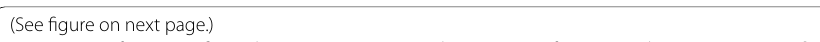
figure on next Fig. 2 Map of site‑specific N ‑glycan processing onto the structure of HIV‑1 envelope: a JR‑FL strain, b BG505 strain, and c B41 strain. The fully glycosylated models were created with JR‑FL ΔCT (PDB: 5FUU), BG505 SOSIP (PDB: 5FYK), and B41 SOSIP. The surfaces of the trimers are represented in grey, and the glycans are represented as spheres colored by the proportion of oligomannose content at that site. The glycans are shown in ball‑and‑stick representation: > 75% high mannose (green), > 75% complex type glycosylation (purple), mixture of high mannose and complex type glycosylation (25% < high‑mannose glycosylation < 75%) (yellow), and the glycosites that were not detected (gray)